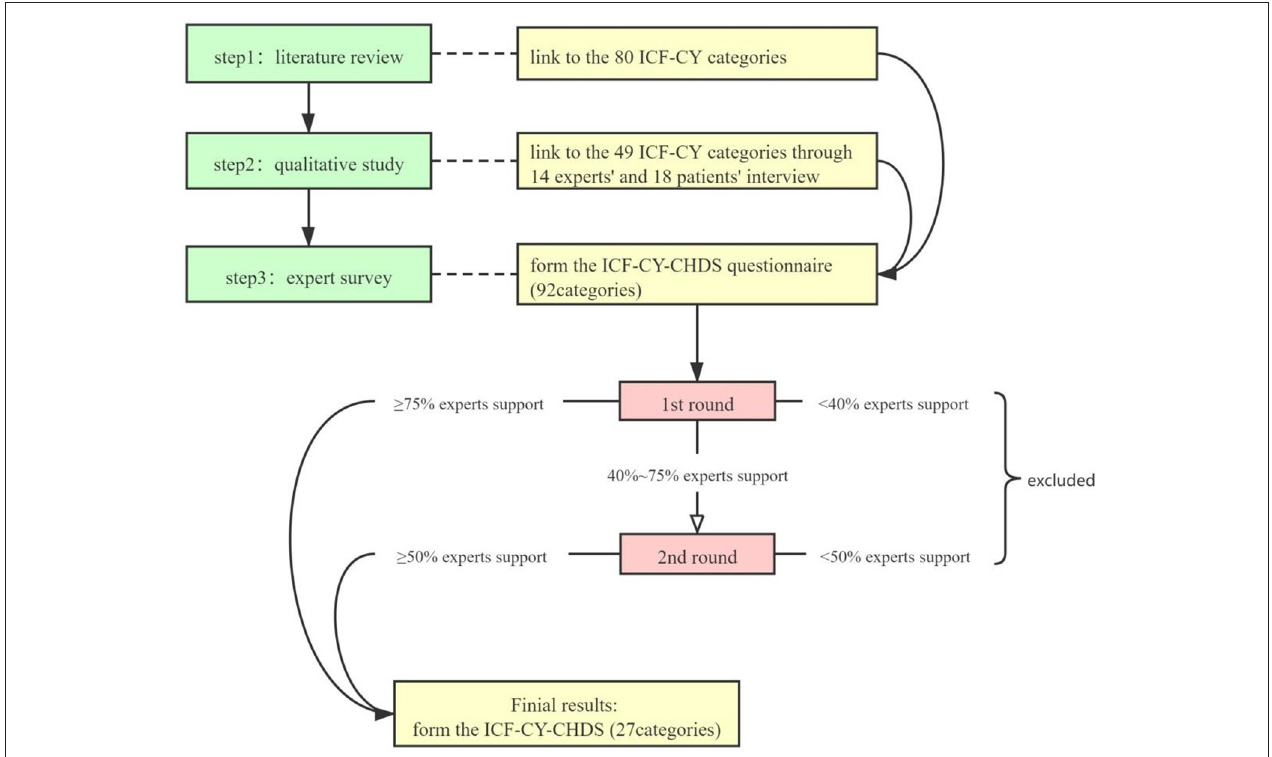
FIGURE 1 | Flow chart of building the